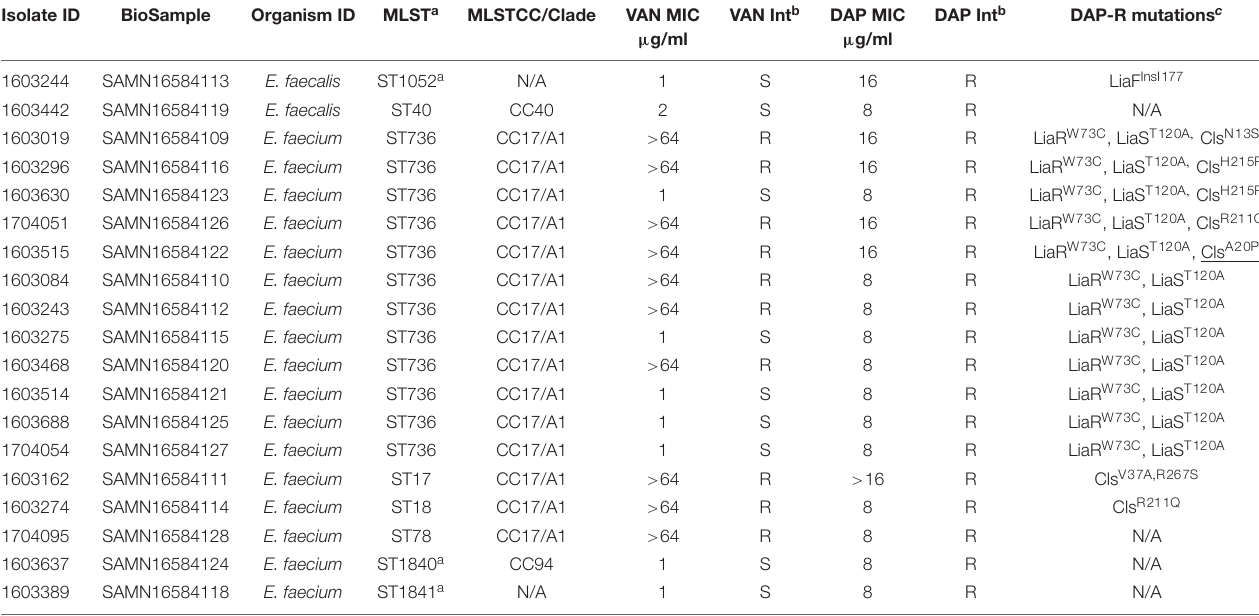
TABLE 1 | Characteristics of E. faecalis and E. faecium CDC Sentinel Surveillance isolates with daptomycin resistance. Isolate ID BioSample